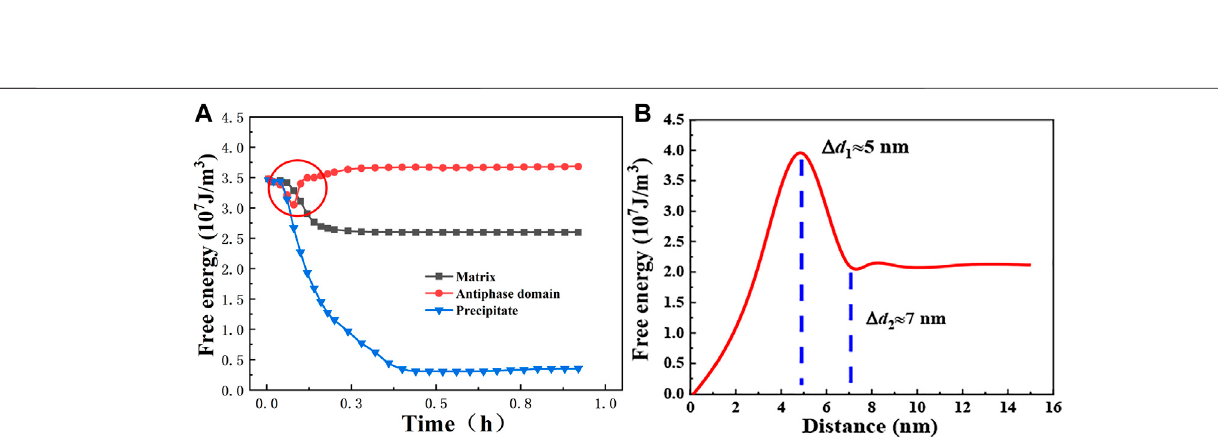
In Figure 1A – D , each γ ʹ phase has reached the equal value 1 or – 1 of order parameters at 1 h. As indicated in the red block, four APDs with different order parameters η max collide with the neighbor one to form the APBs. Previous studies have shown